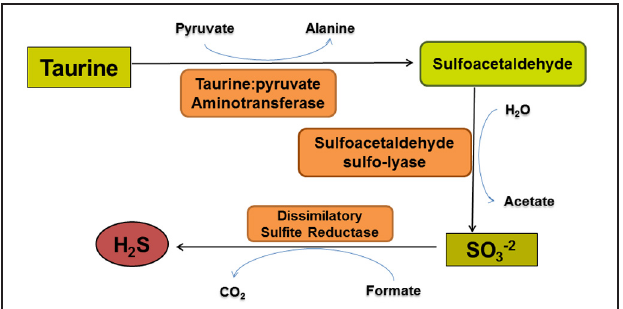
FIGURE 4 | The taurine degradation pathway of Bilophila wadsworthia . Bilophila wadsworthia is the only known intestinal microbe that uses taurine as an electron acceptor for anaerobic respiration. The first two enzymatic reactions result in sulfite production. Sulfite is subsequently converted to H 2 S by a dissimilatory sulfite reductase that differs structurally from those used by sulfate-reducing